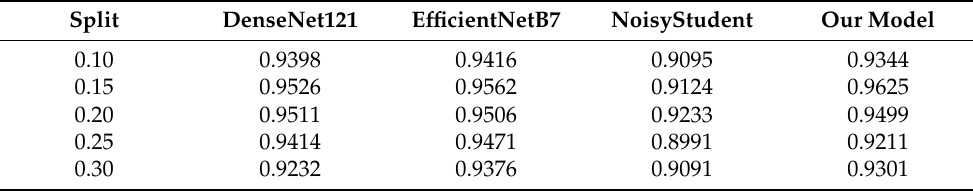
Table 1. Accuracy of the pre-trained and proposed model at various split ratios.